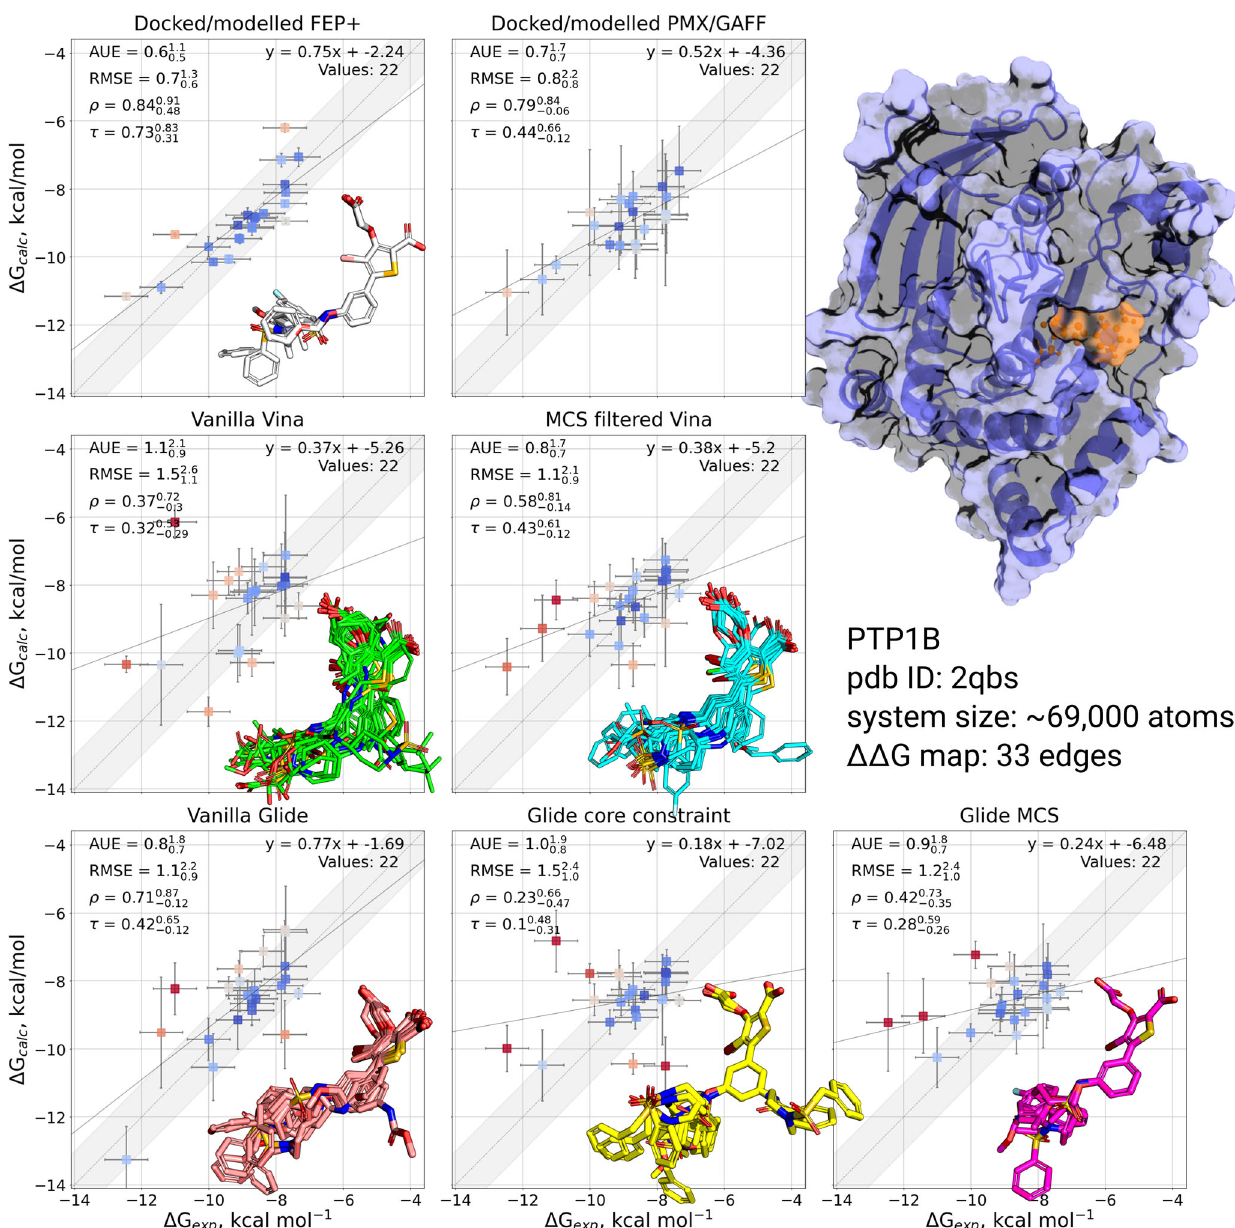
Fig. 2 Comparison of experimentally measured and calculated binding af fi nities for PTP1B protein-ligand system. The simulations were initialized with different starting structures (docked/modelled or docked only). The data in the panel Docked/modelled FEP + and Docked/modelled PMX/GAFF are from Gapsys et al. 3 . Overlays of starting ligand poses are inset into the corresponding plot. Experimental errors are taken from the original publication, whilst prediction errors correspond to the standard error over 3 simulation replicas also taking into account the bootstrapped uncertainty of individual free energy estimates. The shaded grey region corresponds to a 1 kcal mol − 1 deviation from experiment, and the solid line is a linear fi t through the data. The crystal structure with a bound ligand highlighted in orange is shown in the top predicted differently from the modelled poses in all but the Glide MCS protocols. Similarly to P38 α , a fallback core constraint of 1 Å was required to allow the remaining ligands to dock with the fi xed core constraint, which resulted in a fl ipped core being observed for several poses in the Glide core-constrained protocol. Vanilla Glide docking also suffered from a poorly positioned core in some cases (Fig. 2). Vanilla Vina generated a mix of core orientations: in 8 out of 23 ligands the pose was reversed in comparison to the modelled compounds. The MCS- fi ltered Vina protocol had no such pose inversions, which is re fl ected in the reduced AUE (1.1 vs 0.8 kcal mol − 1 ) and RMSE (1.5 vs 1.1 kcal mol − 1 ).